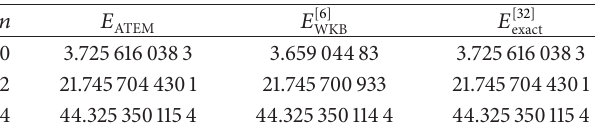
Table 5: Comparison of energy eigenvalues of the potential in (19) for 𝑛 = 0, 2, 4